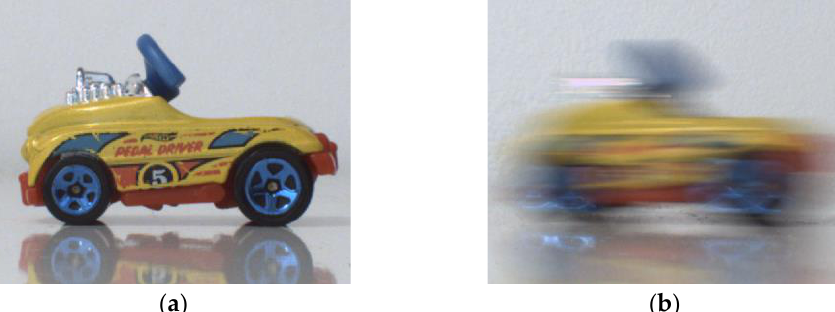
Figure 11. Example of motion acquisition with a standard exposure time (here 50 ms). ( a ) Acquisition of a motionless car; ( b ) Acquisition of a moving car.